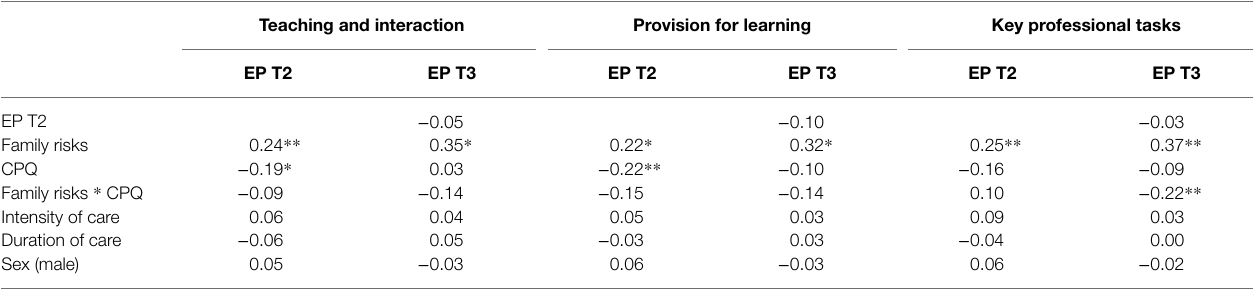
TABLE 5 | Standardized regression coefficients of the model for emotional problems ( N = 293). Teaching and interaction Provision for